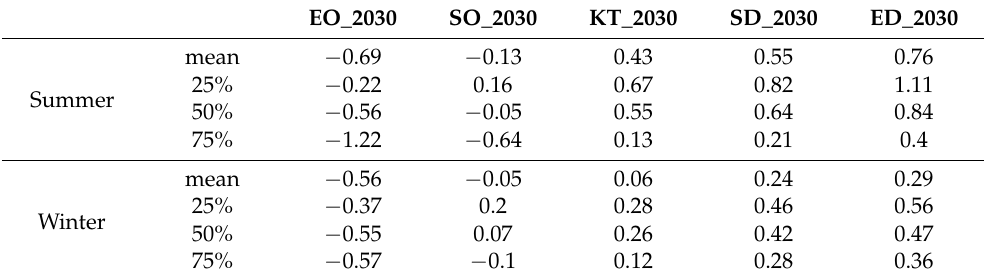
Table A1. UTEI data distribution statistics of all cities in 2030 under five simulated